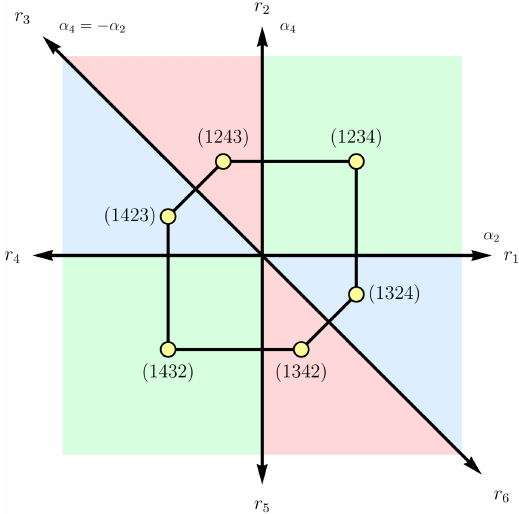
Figure 8 . The permutohedron of order 3 is dual to the complete fan of positive sectors for G + (2 , 4) .